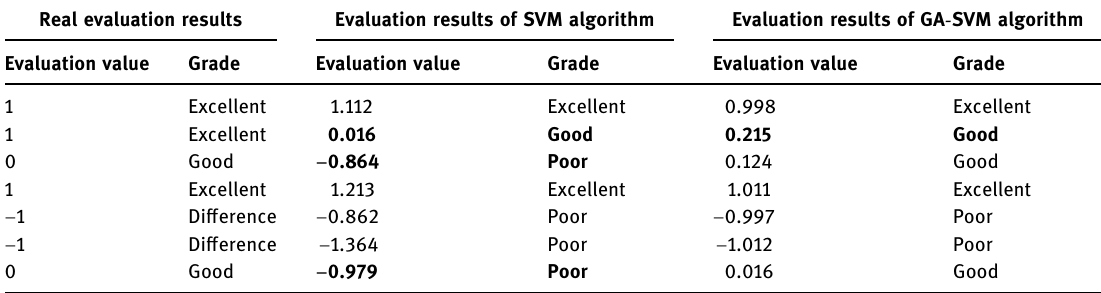
Table 6: Comparison of partial evaluation results